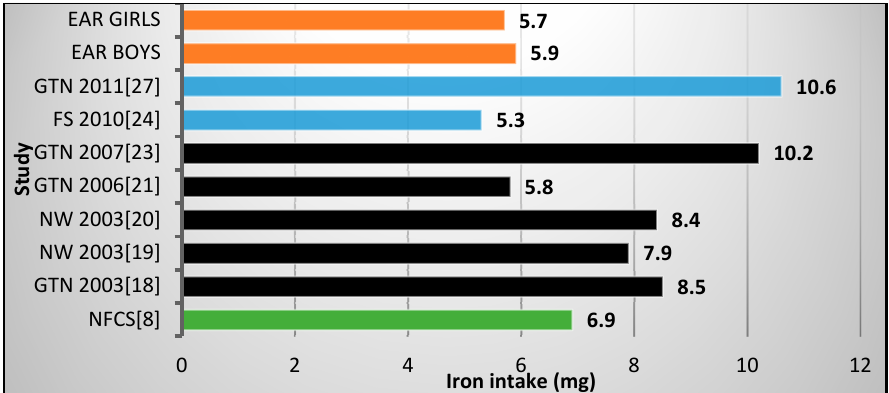
Figure 2. Mean iron intake in studies on schoolchildren in South Africa between 2000 and 2015 with the blue bars representing two studies which included fortification values. EAR: estimated average intake; GTN: Gauteng; FS: Free State; NW: North West; NFCS: National Food Consumption Survey.